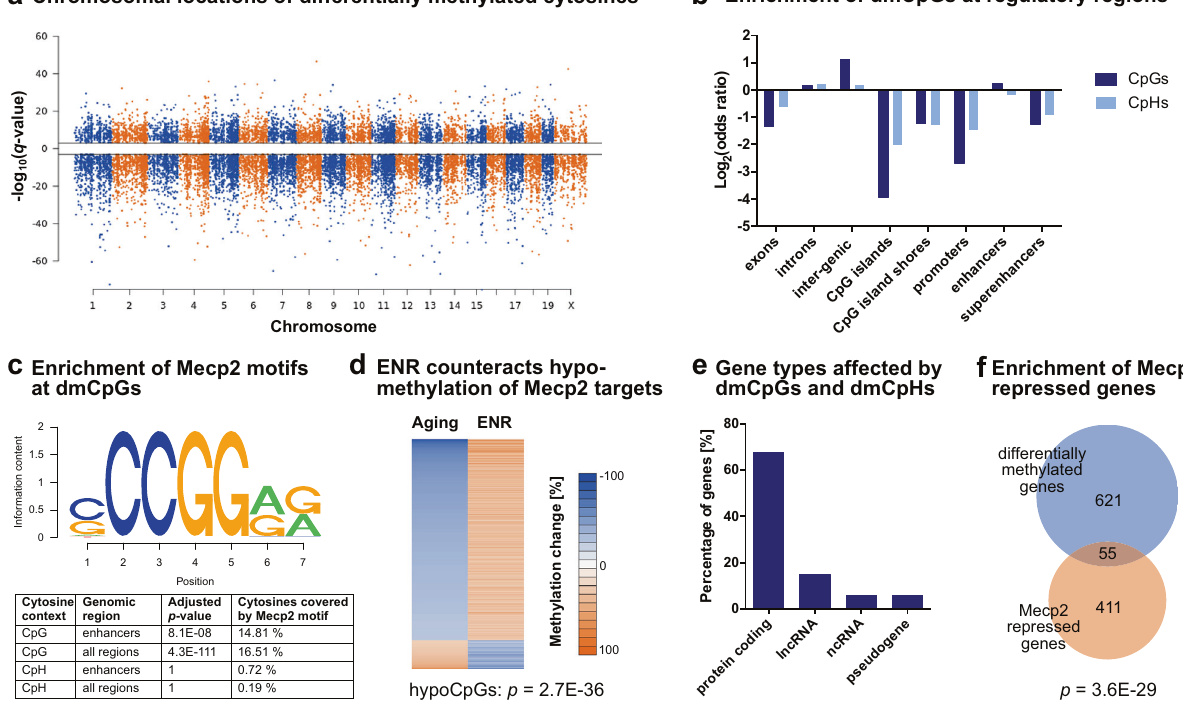
Fig. 3 Genomic distribution of cytosines at which environmental enrichment counteracts age-related methylation changes. a Manhattan plot depicting the distribution of dmCpGs and dmCpHs over chromosomes. Q -values indicate the signi fi cance of the aging-induced methylation changes with the sign corresponding to the direction of the change (negative − log 10 ( q -value) for hypomethylated cytosines; positive − log 10 ( q -value) for hypermethylated cytosines). b CpGs and CpHs are depleted at CpG islands, CpG island shores, promoters, and exons (log 2 (odds ratio) < 0), but enriched at introns and intergenic regions of the genome (log 2 (odds ratio) > 0). In addition, CpGs but not CpHs are enriched at enhancer regions. Adjusted p < 0.001 for all regions, except CpHs at enhancers (adjusted p = 0.061; one-sided linear regression with FDR correction). c Transcription factor binding analysis revealed enrichment of Mecp2 motifs at dmCpGs located within enhancers (1472 CpGs) as well as at all regulated 13,314 dmCpGs (independent of genomic location). Mecp2 motifs were not enriched at dmCpHs. Depicted are the Mecp2 motif as annotated in the database motifDb and the results of the enrichment analysis (one-sided hypergeometric test with FDR correction). d The 2198 dmCpGs that fall into Mecp2 targets sites are enriched with CpGs that were hypomethylated with aging ( p -value from one-sided hypergeometric test compared to all 13,314 CpGs). e Classi fi cation of gene targets of cytosines at which ENR counteracts aging-induced methylation changes (676 differentially methylated genes). f Previously identi fi ed Mecp2-repressed genes 68 are enriched among the differentially methylated genes ( p -value from the one-sided hypergeometric